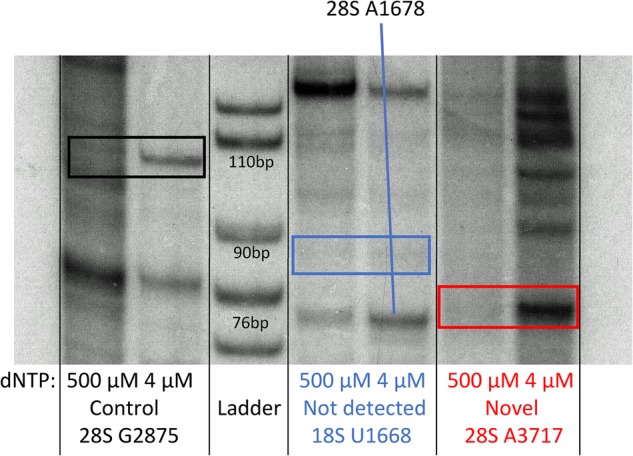
Primer extension analysis. For novel site validation, primers were P32 labeled. One microgram of total RNA, 1 µL (10 µM) labeled RT primer, 1 µL 100 µM or 1 µL 10 mM (control) concentrations of dNTPs, 7 µL of water were denatured at 65°C for 5 min, then chilled on ice. An RT Master mix (10 µL per reaction) containing 2 µL 10× RT Buffer, 1 µL (40 U) RNase Out, 1 µL AMV RT (NEB), and 6 µL water was prepared, and added to the RNA/primer mix. Incubation was at 42°C for 45 min. Reactions were ethanol precipitated and resuspended in loading buffer for TBE-PAGE electrophoresis. This experiment was performed for three selected sites from RibOxi-seq: positive control at 28S C1880 (lanes 1,2), known but not detected 18S U1668 (lanes 4,5) and newly detected and not previously reported 28S A3717 (lanes 6,7). The first lane of each set is a negative control where primer extension was performed with a higher dNTP concentration. The second lane of each set was performed at low dNTP concentration to promote polymerase pausing at sites of 2′-OMe.